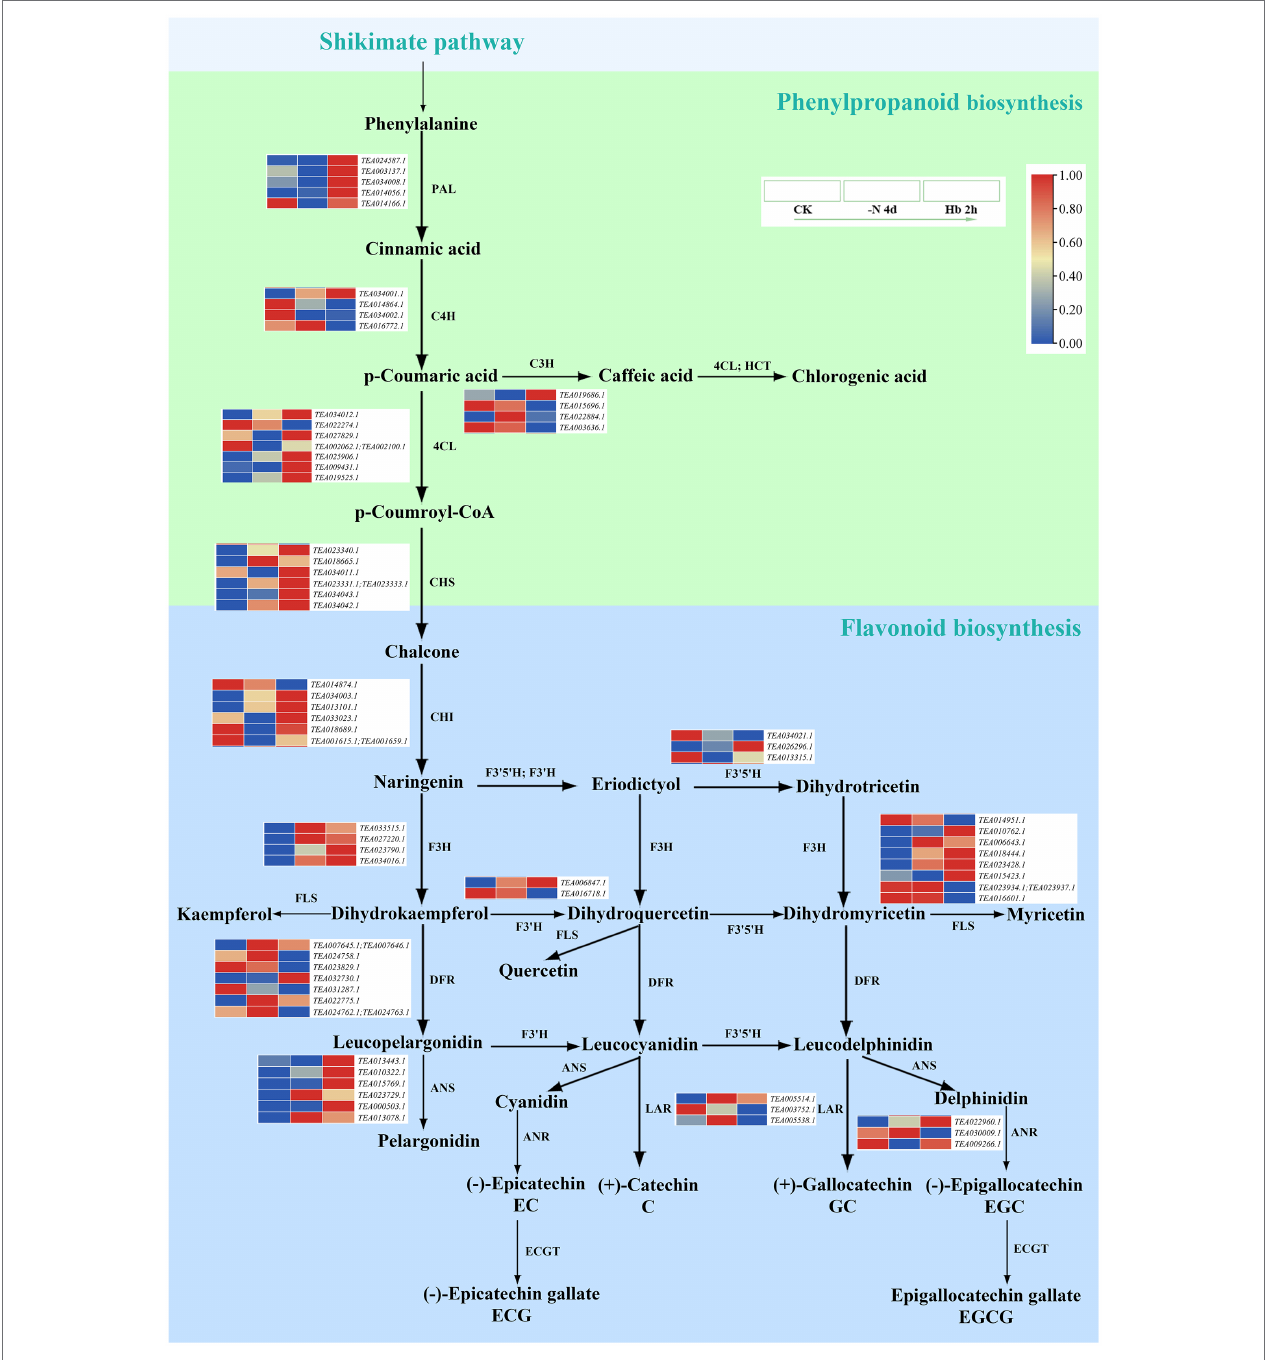
FIGURE 5 | The expression of key genes in the polyphenol metabolic pathway in C. sinensis roots during N deprivation and resupply. Relative expression levels are shown by a color gradient from low (blue) to high